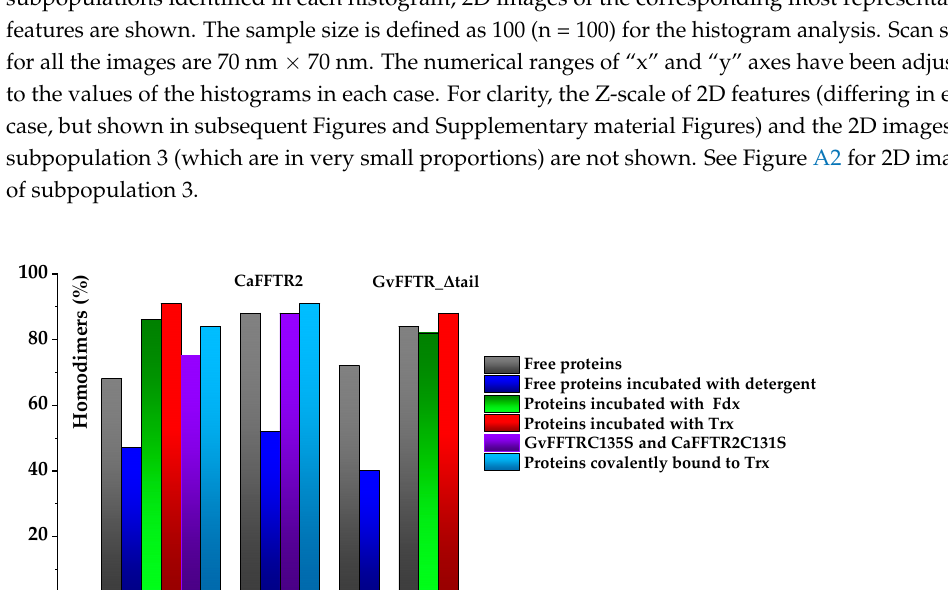
Free proteins Free proteins incubated with detergent Proteins incubated with Fdx Proteins incubated with Trx GvFFTRC135S and CaFFTR2C131S Proteins covalently bound to Trx